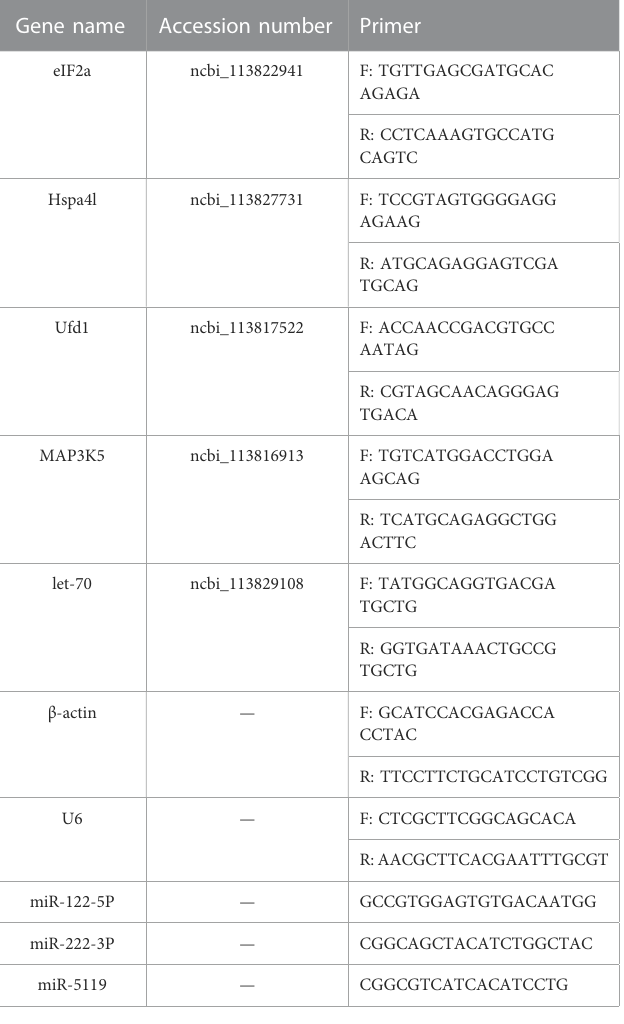
TABLE 1 mRNA and miRNA primers used for qRT-PCR validation.